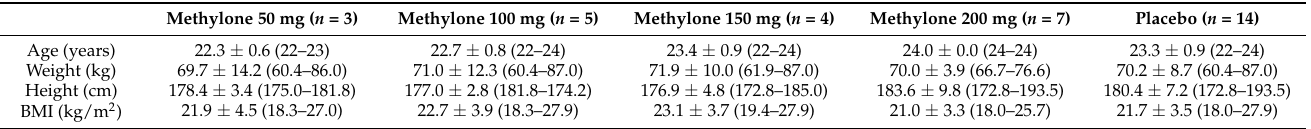
Table 1. Characteristics of the